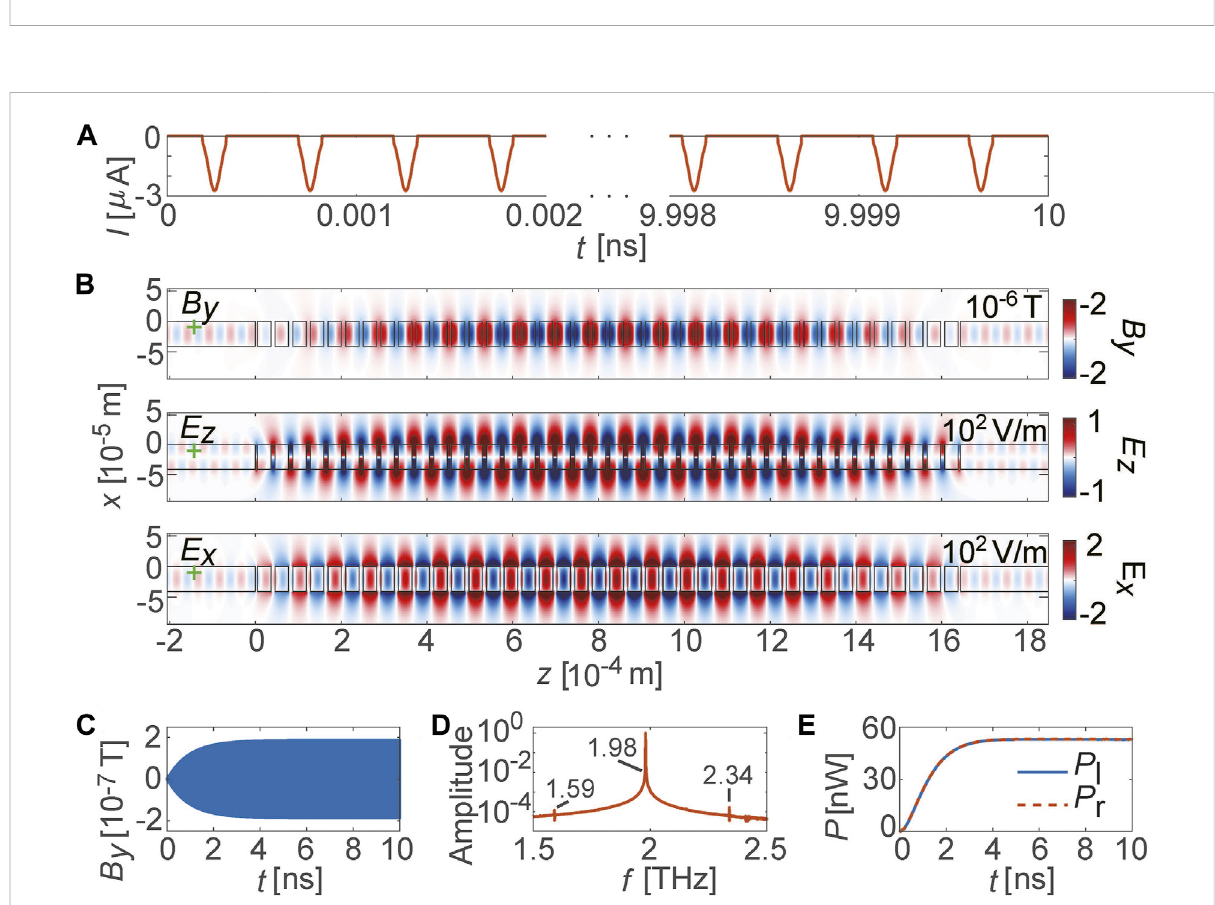
FIGURE 4 CoherentterahertzradiationcalculatedbyPICsimulationwith f b =1.9807 THz. (A) Thecurrentoftheelectronbeam. (B) Fieldpatternsofthe B y , E z , E x components at t =10 ns. (C) B y fi eld atthe green star in (B) as afunction of time. (D) Spectrum ofthe B y fi eld atthegreen starin (B) . (E) Leftward output power P l through the slab waveguide on the left and rightward output power P r through the slab waveguide on the